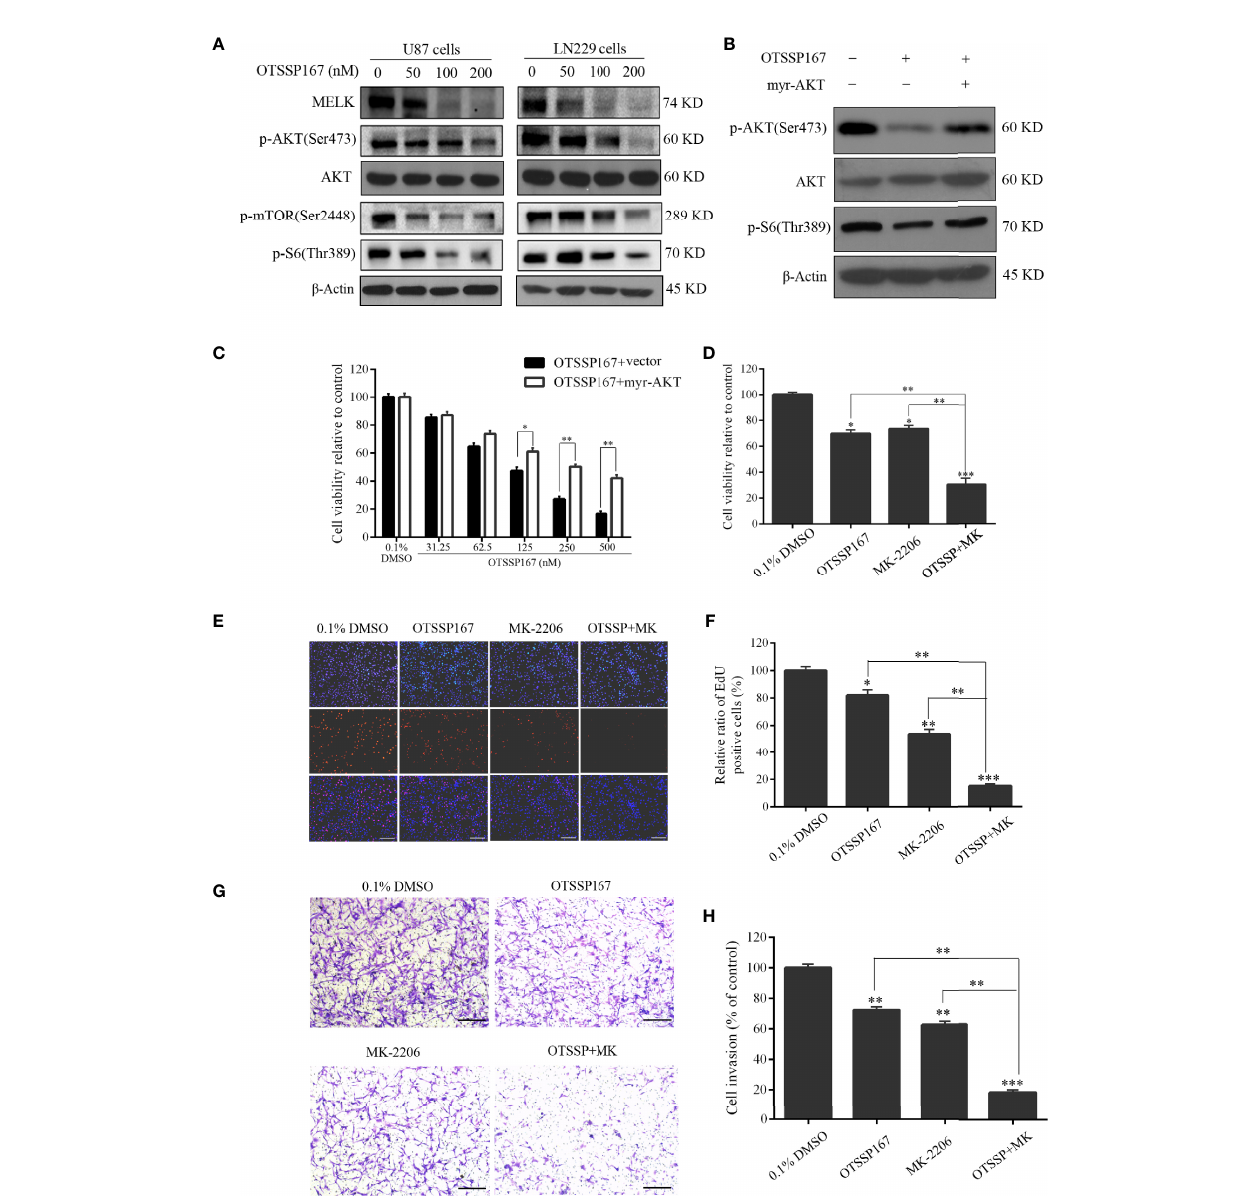
FIGURE 4 | OTSSP167 reduces MELK protein expression and blocks AKT pathway activation, thereby inhibiting the proliferation and invasion of GBM cells. (A) U87 and LN229 cells were treated with OTSSP167 for 24 h. Western blotting showing the expression levels of MELK, p-AKT(Ser473), AKT, p-mTOR(Ser2448), and p-S6 (Thr389) proteins. (B) U87 cells transfected with myr-AKT plasmid were treated with OTSSP167, followed by western blotting to assess changes in p-AKT(Ser473), AKT, and p-S6(Thr389) expression. (C) CCK-8 assay shows the effects of OTSSP167 treatment on U87 cells transfected with myr-AKT plasmid compared to the control group. (D) CCK-8 assay showing the viability of U87 cells treated with 50 nM OTSSP167 and 1 m M MK-2206 (AKT inhibitor) alone or combined OTSSP167 and MK-2206 treatment for 72 h. (E) Measurement of cell proliferation after treating with 50 nM OTSSP167 and 1 m M MK-2206 alone or their combinations by EdU incorporation assay. (F, H) Quantitative analysis of proliferative and invading cell numbers. The numbers of proliferative and invading cells were normalized to that of the control group. (G) U87 cells were incubated with 50 nM OTSSP167 and 1 m M MK-2206 alone or their combinations. Cell invasive abilities were evaluated by transwell assay. Results were expressed as means ± SEM of three independent experiments. * P < 0.05, ** P < 0.01 and *** P < 0.001 compared with control group.